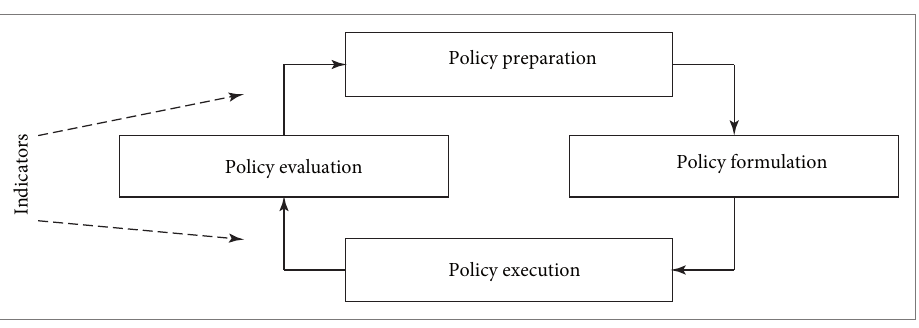
Fig. 1. The policy cycle. Source: Bosch 2001: